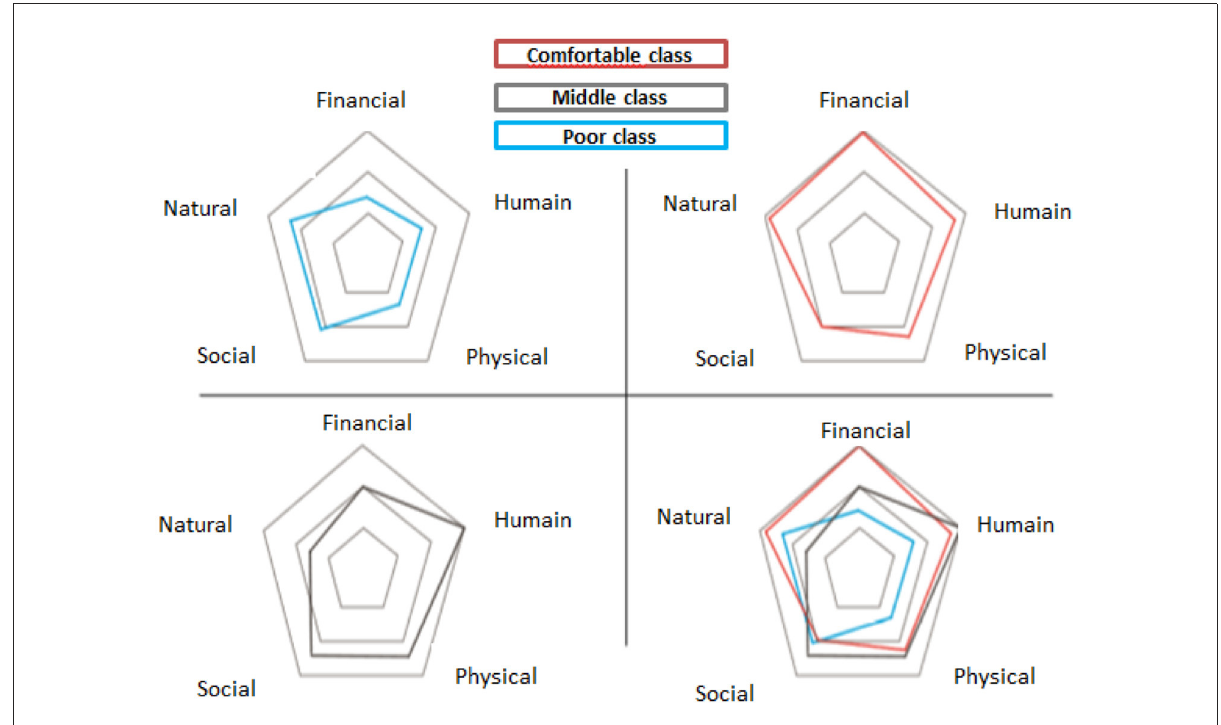
FIGURE12 Pentagons of assets according to social groups in the Amskroud commune.